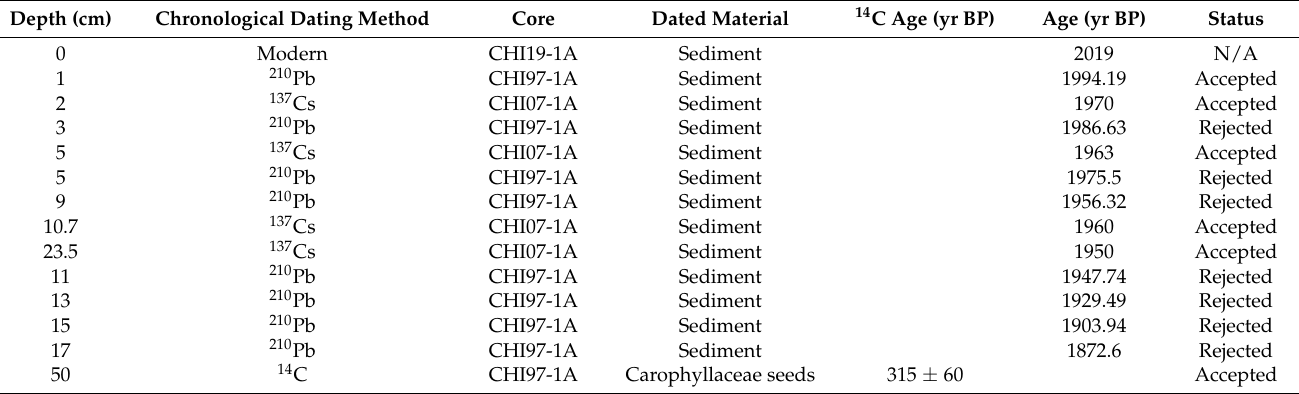
Table 2. 210 Pb, 137 Cs and 14 C dates for associated cores. The carbon-14 date is from [49], 210 Pb and 137 CS dates provided by the Instituto Pirenaico de Ecologia